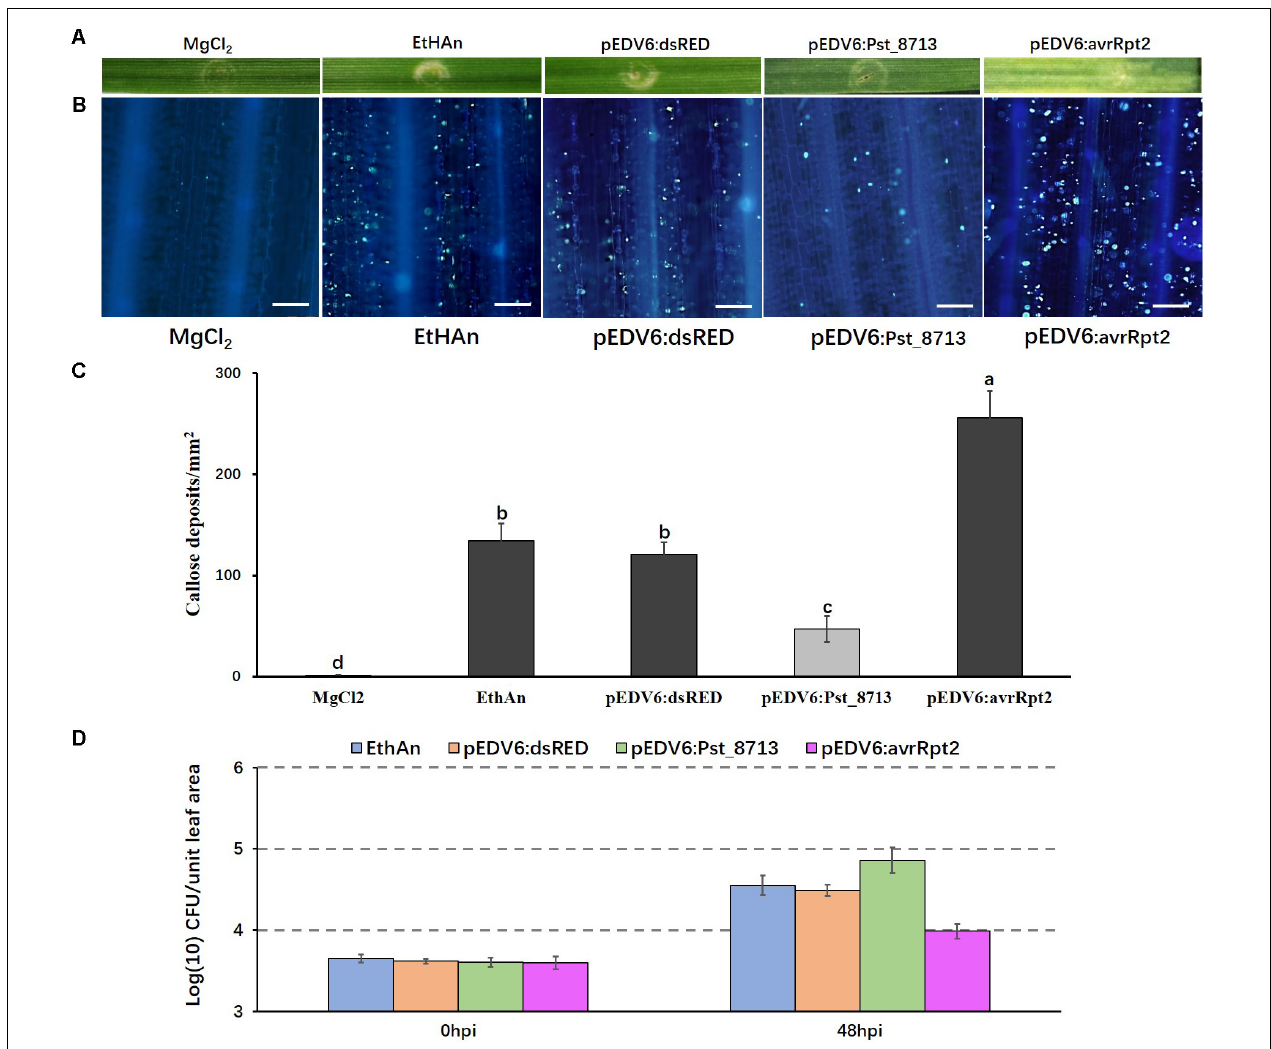
FIGURE 5 | Overexpression of Pst_8713 in wheat (AvS) suppressed PTI-related callose deposition. (A) Phenotypes of the wheat leaves infiltrated with the MgCl 2 buffer (MOCK), EtHAn, pEDV6:dsRED, pEDV6:Pst_8713, and pEDV6:AvrRpt2at 72 h after infiltration. (B) The wheat leaves inoculated with MgCl 2 buffer, EtHAn, pEDV6:dsRED, pEDV6:Pst_8713, or pEDV6:AvrRpt2 were examined for callose deposition by epifluorescence microscopy after aniline blue staining. Bar = 100 µ m. (C) Average number of callose deposits/mm 2 in wheat leaves inoculated with MgCl 2 buffer, EtHAn, pEDV6:dsRED, pEDV6:Pst_8713, or pEDV6:AvrRpt2. Bars indicate means ± SE of three independent biological replicates with 30 unit areas per replicate. The different letters indicate significant differences ( P < 0.05) according to analysis of variance (ANOVA). (D) Bacterial growth in EtHAn, pEDV6:dsRED, pEDV6:Pst_8713, or pEDV6:AvrRpt2 infiltrated wheat leaves. Numbers of bacteria were evaluated at 0 and 48 hpi. Each time-point is average of three biological replicates. Bacteria in wheat inoculating with EthAn carrying pEDV6:Pst_8713 grew ∼ 2.75-fold better than EthAn carrying